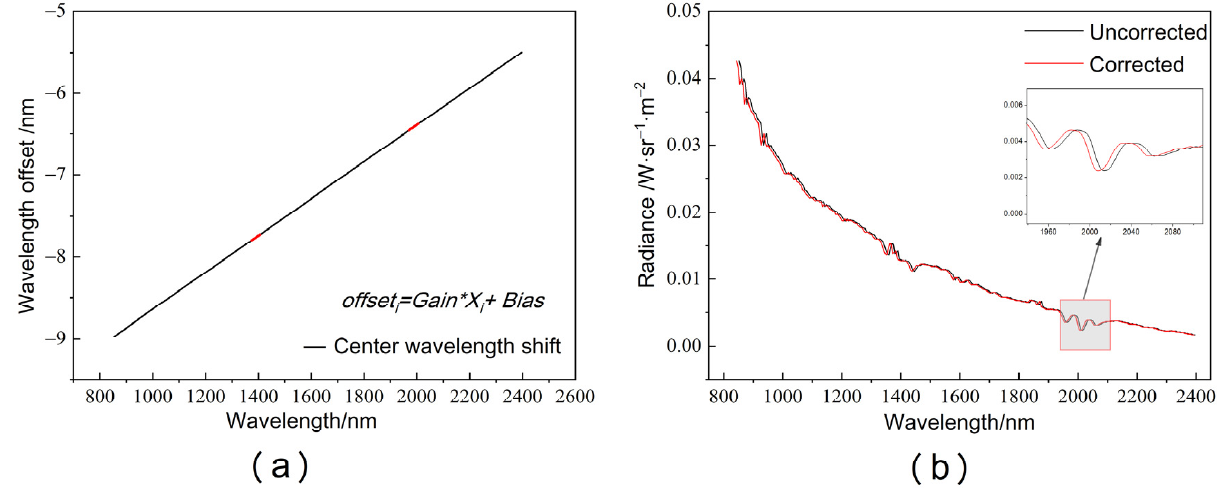
Figure 6. Solution for the full spectrum offset value and the effect are shown: ( a ) Fitted curve of wavelength offset value of the full spectrum of hyperspectral data; ( b ) radiation brightness curve before and after spectral calibration (black indicates the radiation brightness curve before wavelength correction; red indicates the radiation brightness curve after correction).